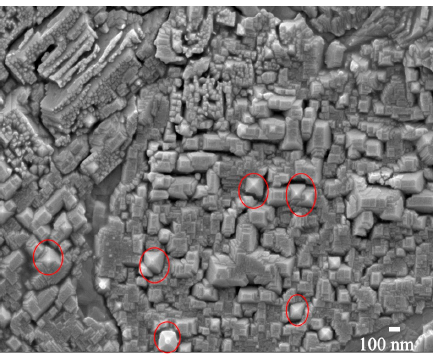
Figure 4. FESEM image of Bi 2 O 3 :Ho 3+ thin film deposited with substrate temperature 600 °C, and the tetragonal bipyramids are marked with red circles.